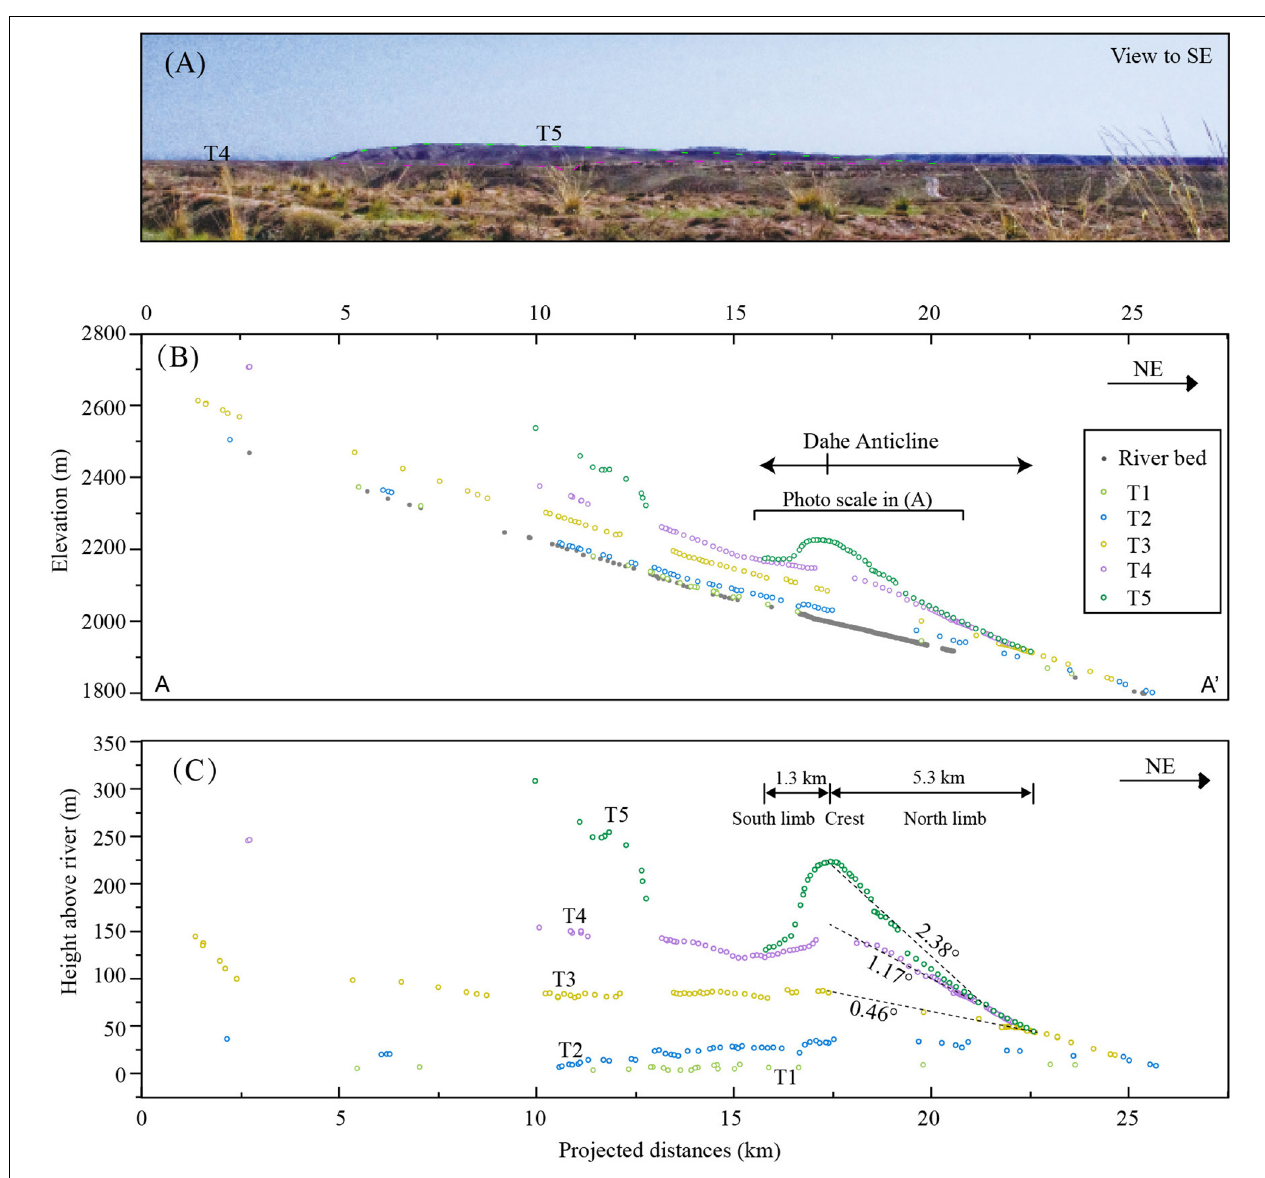
FIGURE 4 | (A) The photo of the folded terrace surface of T5 at the anticline. (B) The longitudinal profiles of terrace surfaces and the modern river bed. The distance is along the straight line of A–A (cid:48) in Figure 2 , and each surveyed point is projected to this line. (C) The heights of terrace surfaces along the Bailang River. The height data for the terrace surfaces are calculated by subtracting the elevation of modern river bed from the elevation of terrace